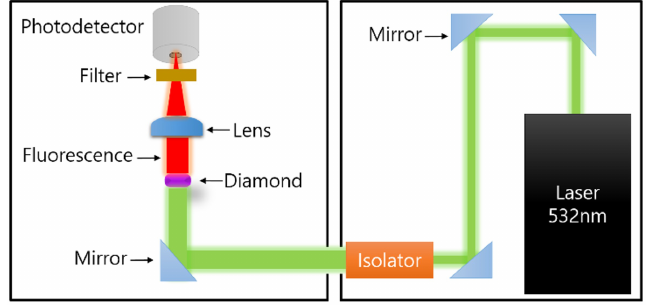
Figure A2. Schematic of the laser optical